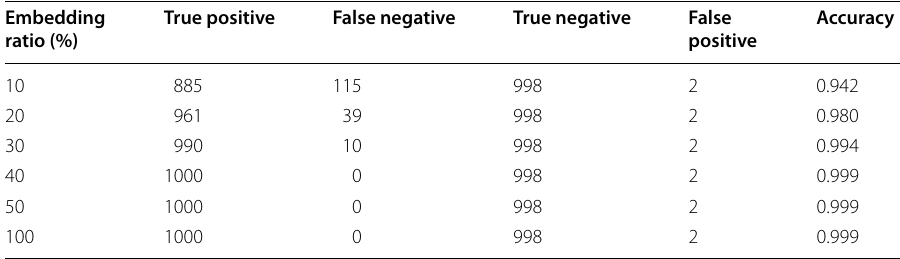
Table 3 indicates that the accuracy of the proposed method is high, with more than 90% of the samples correctly identified, even at low embedding ratios.